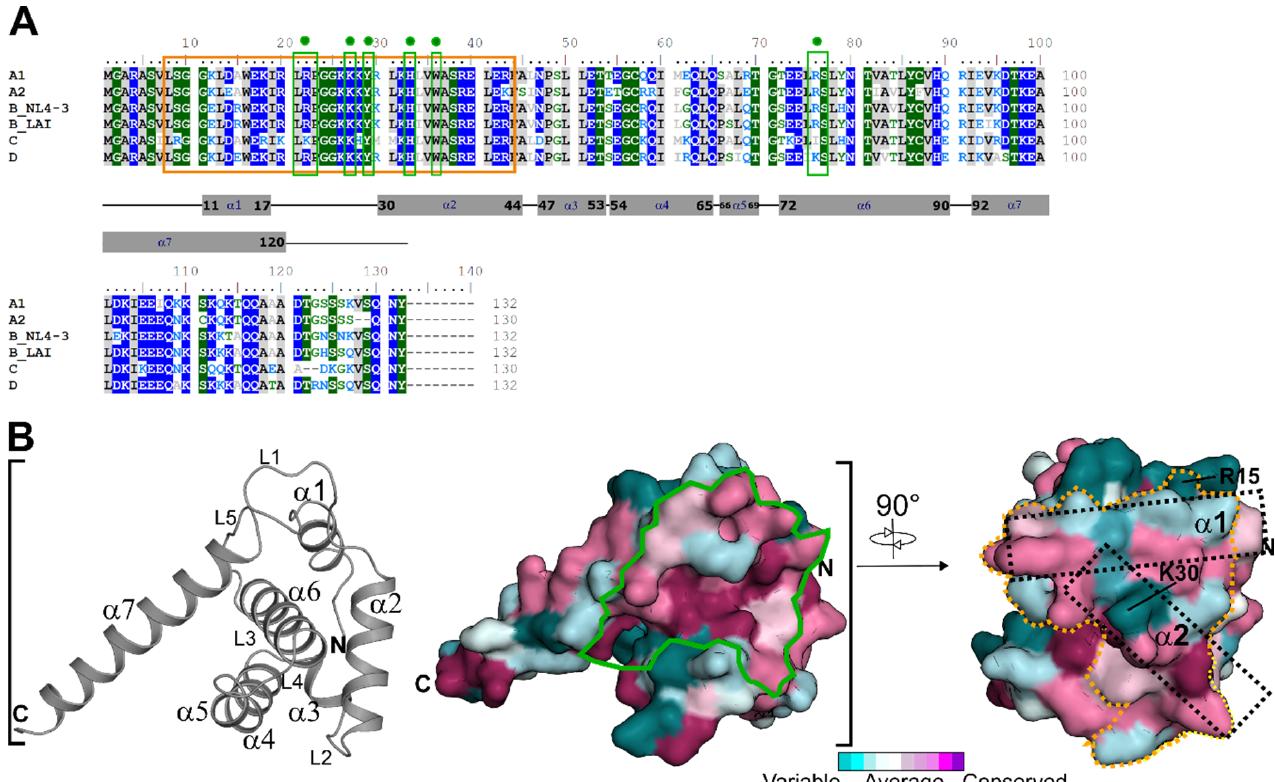
Figure 1. Multiple sequence alignment of HIV-1 MA clades used in this study and evolutionary conservation. ( A ) Amino acid sequences of HIV-1 MA protein from clade A1 (92UG037.1, GenBank accession no. AAC97550.1), A2 (CDKTB48, GenBank accession no. AF286238.1), B (NL4-3, GeneBank accession no. AF003887.1), C (92BR025.8, GenBank accession no. U52953.1), D (94UG114.1, GenBank accession no. U88824.1) were aligned using Clustal Omega [33] and manually adjusted in BioEdit. Residues with greater than 70% conservation are color-shaded (hydrophilic residues are in blue, neutral in green, and hydrophobic in grey). The yellow box insert highlights residue 8-43, the CaM binding motif. The green box inserts with a circle highlight the residues involved in di-C4-PI(4,5)P 2 binding. Sequence identity in comparison to HIV-1 clade B (NL4-3): A1 (92UG037.1): 82.6%, A2 (CDKTB48): 78.8%, B(LAI): 93.2%, C (92BR025.8): 72.0% (68.3% within residue 8-43), and D (94UG114.1): 81.1%. ( B ) Secondary structure (loop: L, α : alpha-helix) and conservation analysis of the HIV-1 MA protein based on the MSA in panel A. Conservation is represented on the surface of HIV-1 MA from clade B (PDB code: 1HIW). The solid green line indicates the PI[4,5]P2/nucleic acid binding site, while the dotted orange line indicates the CaM binding motif. Dotted black rectangles highlight helix α -1 and α -2 within the CaM binding motif.